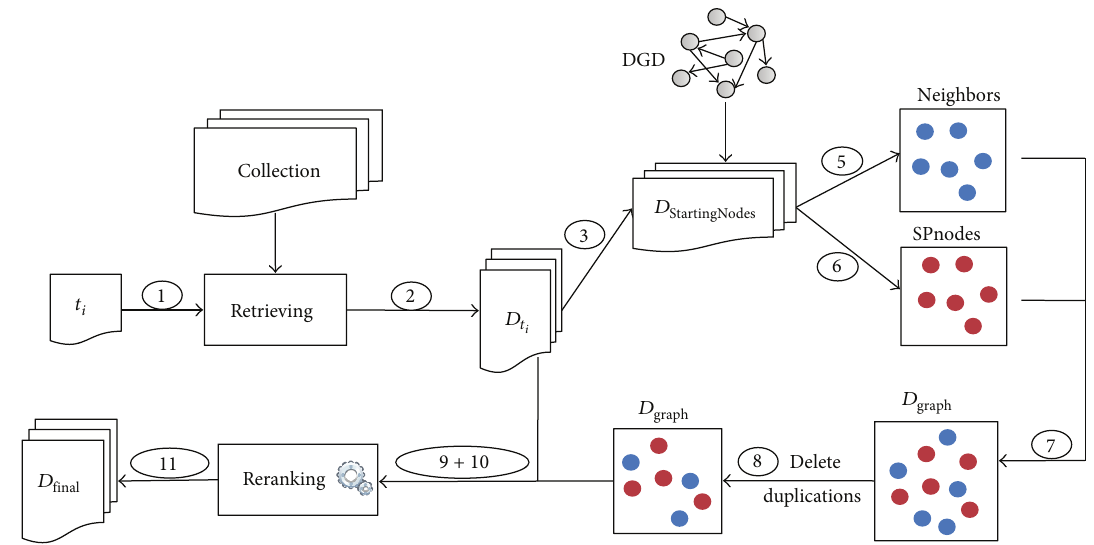
Figure 3: Architecture of book retrieval approach based on DGD